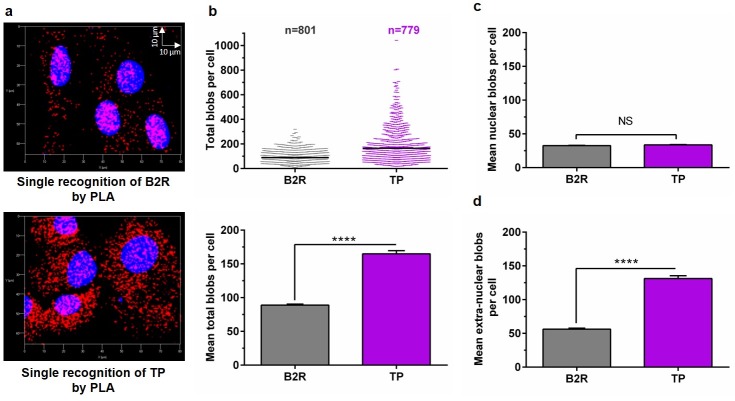
Quantitative analysis of single GPCR (B2R or TP) occupancy in VSMC using PLA.(a): Representative 3D maximum intensity projection of z-stack images obtained for RASMC analyzed by PLA for single B2R or TP expression at basal conditions (red). Nuclei appear in blue. (b): Scatter plot representing single cell analysis of the total number of PLA blobs per cell for B2R (n = 801 cells) or TP (n = 779 cells). The mean total blobs per cell is also plotted for B2R versus TP. Bar graphs representing mean ± SEM of nuclear blobs (c) or extra-nuclear blobs (d) per cell were plotted for B2R or TP. Statistical analysis was conducted using Mann-Whitney Rank Sum t-test. N = 3 independent experiments. (NS): not statistically significant; (****): p ≤ 0.0001.